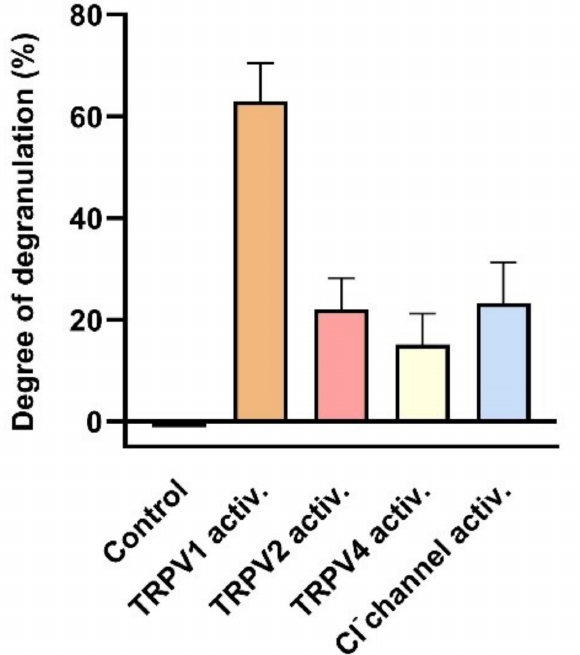
Figure 10. Degranulation of human MCs induced by activation of TRPV1, TRPV2, TRPV4 and stretch- activated (SA) Cl − channels. Degranulation was determined as degree of degranulation induced by the TRPV1 activator capsaicin (1 µ M) (data extracted from Gu et al. (2012) [48]), or as the contribution sensitive to specific inhibitors: 20 µ M SKF96365 for TRPV2 to degranulation induced by hypotonic stress (230 compared with310 mOsm/L) (data extracted from (Wang and Schwarz (2012) [60]), or 500 nM HC067047 for TRPV4 to degranulation induced by compound 48/80 (data extracted from Mascarenhans et al. (2017) [61]), or 200 µ M DIDS for the mechanical SA Cl − channel (see Section 3.1.2) (data extracted from Wang and Schwarz (2012) [60]). Data represent averages +